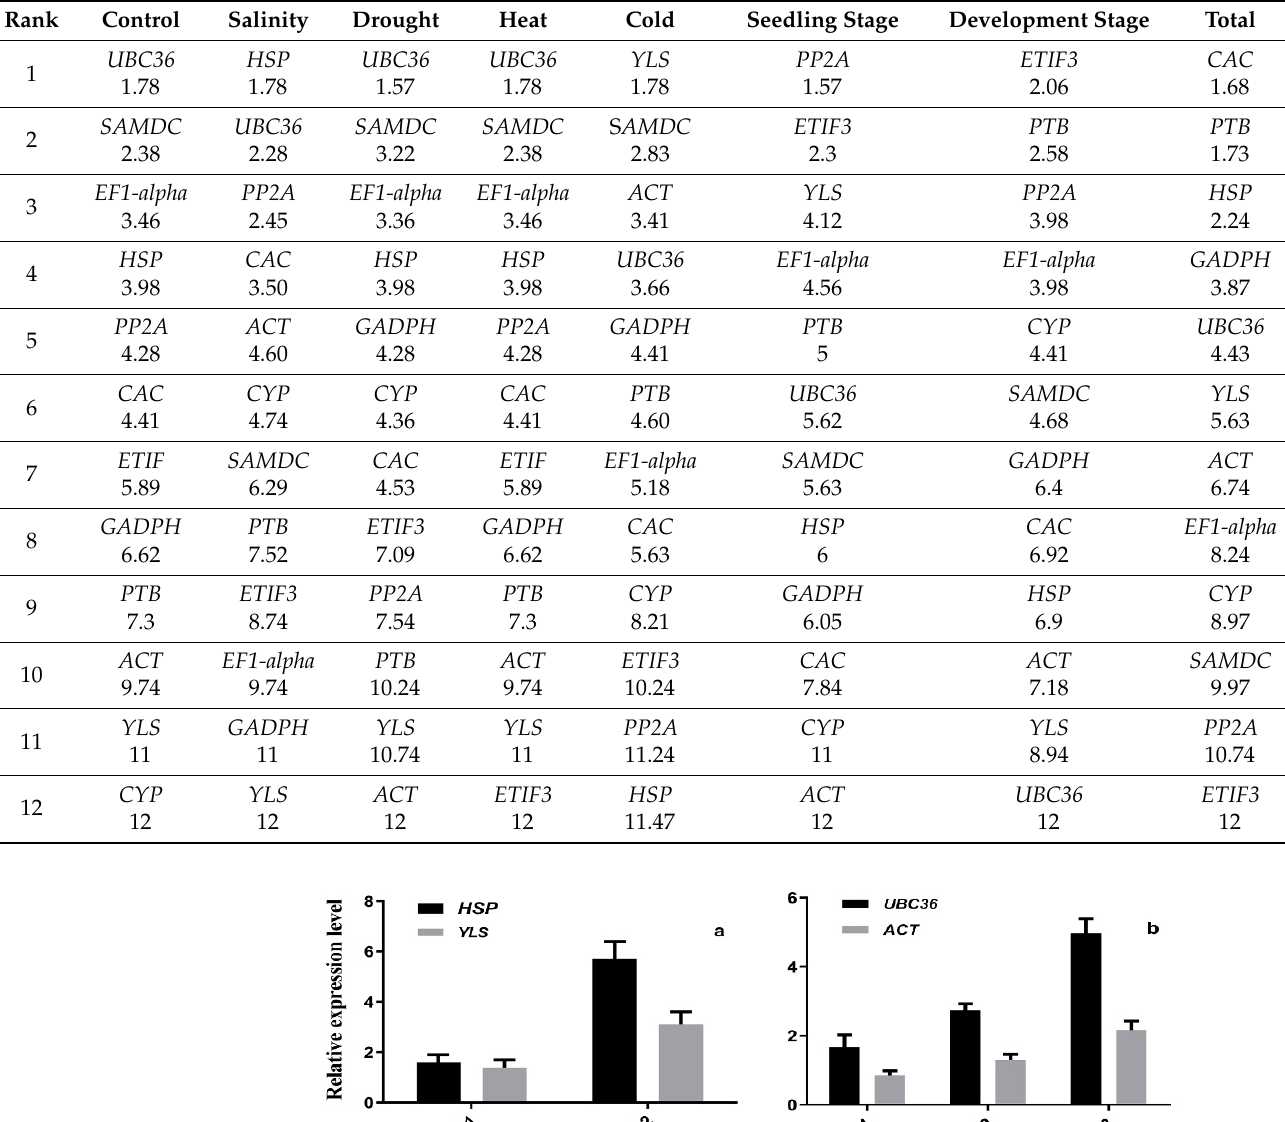
Table 3. Reference gene expression stability ranked by RefFinder under different abiotic stresses and developmental stages in Ae. tauschii .